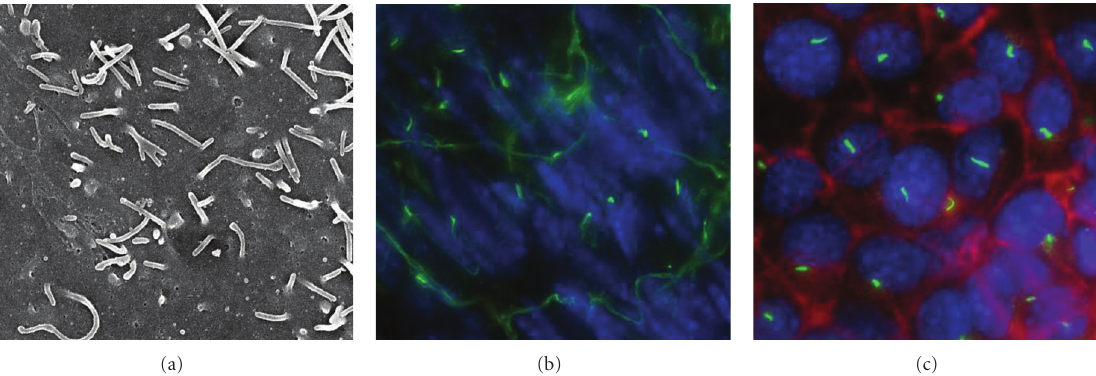
Figure 1: Primary cilia are present in vivo and in vitro. Primary cilia are present in all vestibular organs or tissues with vestibules (canals) that support perfusion of bodily fluid. Shown here are representative images demonstrating the presence of primary cilia in endothelial cells. (a) Scanning electron micrograph shows the presence of primary cilia in the lumen of mouse femoral artery. (b) Immunofluorescence image verify the presence of cilia in the mouse femoral endothelia. (c) When these endothelial cells were isolated, the cells retained their cilia in culture, as depicted in the image. Blue denotes cell nuclei; green represents acetylated- α -tubulin used as a cilia marker; red indicates actin cytoskeleton.